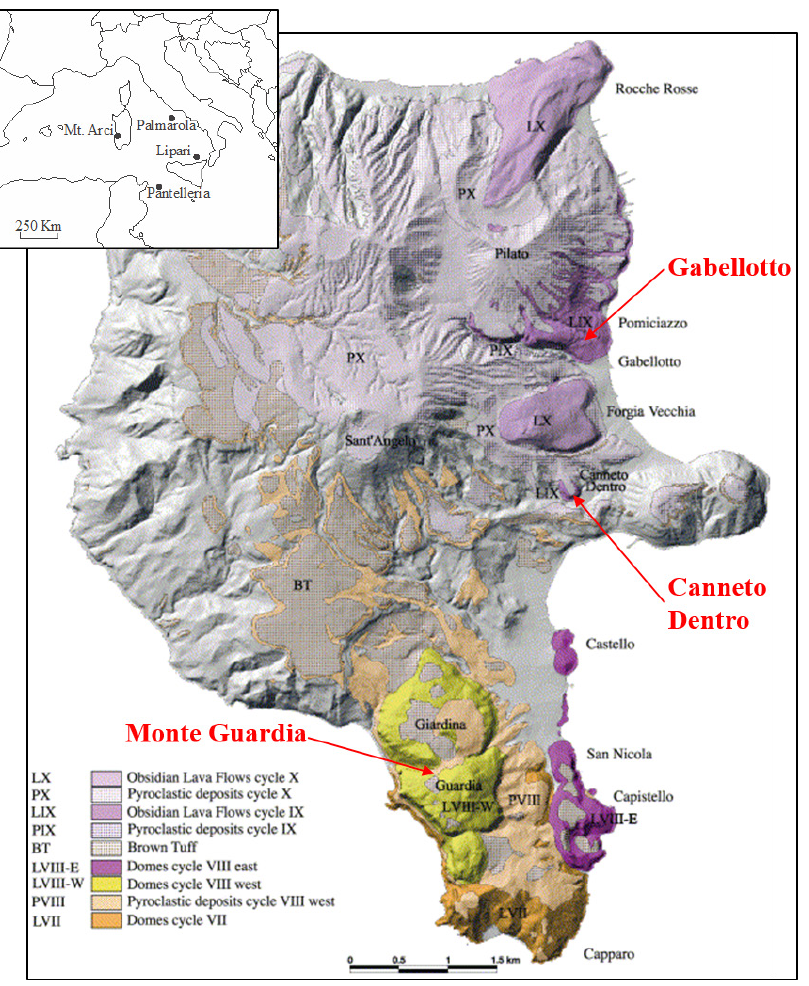
Figure 1. Geological map of Lipari draped on a DEM shaded relief image (modified after Pichler, 1980, Crisci et al., 1991, and Gioncada et al., 2003). The flows for Gabellotto Gorge and Canneto Dentro are dated to the LIX (obsidian lava flows cycle IX) volcanic